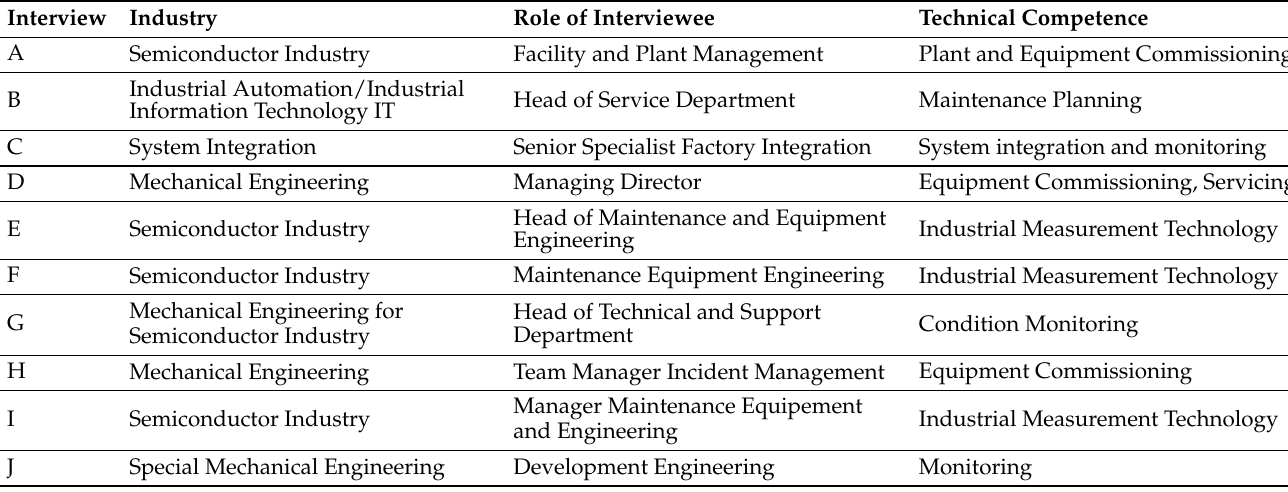
Table A2. The following table lists the general information about